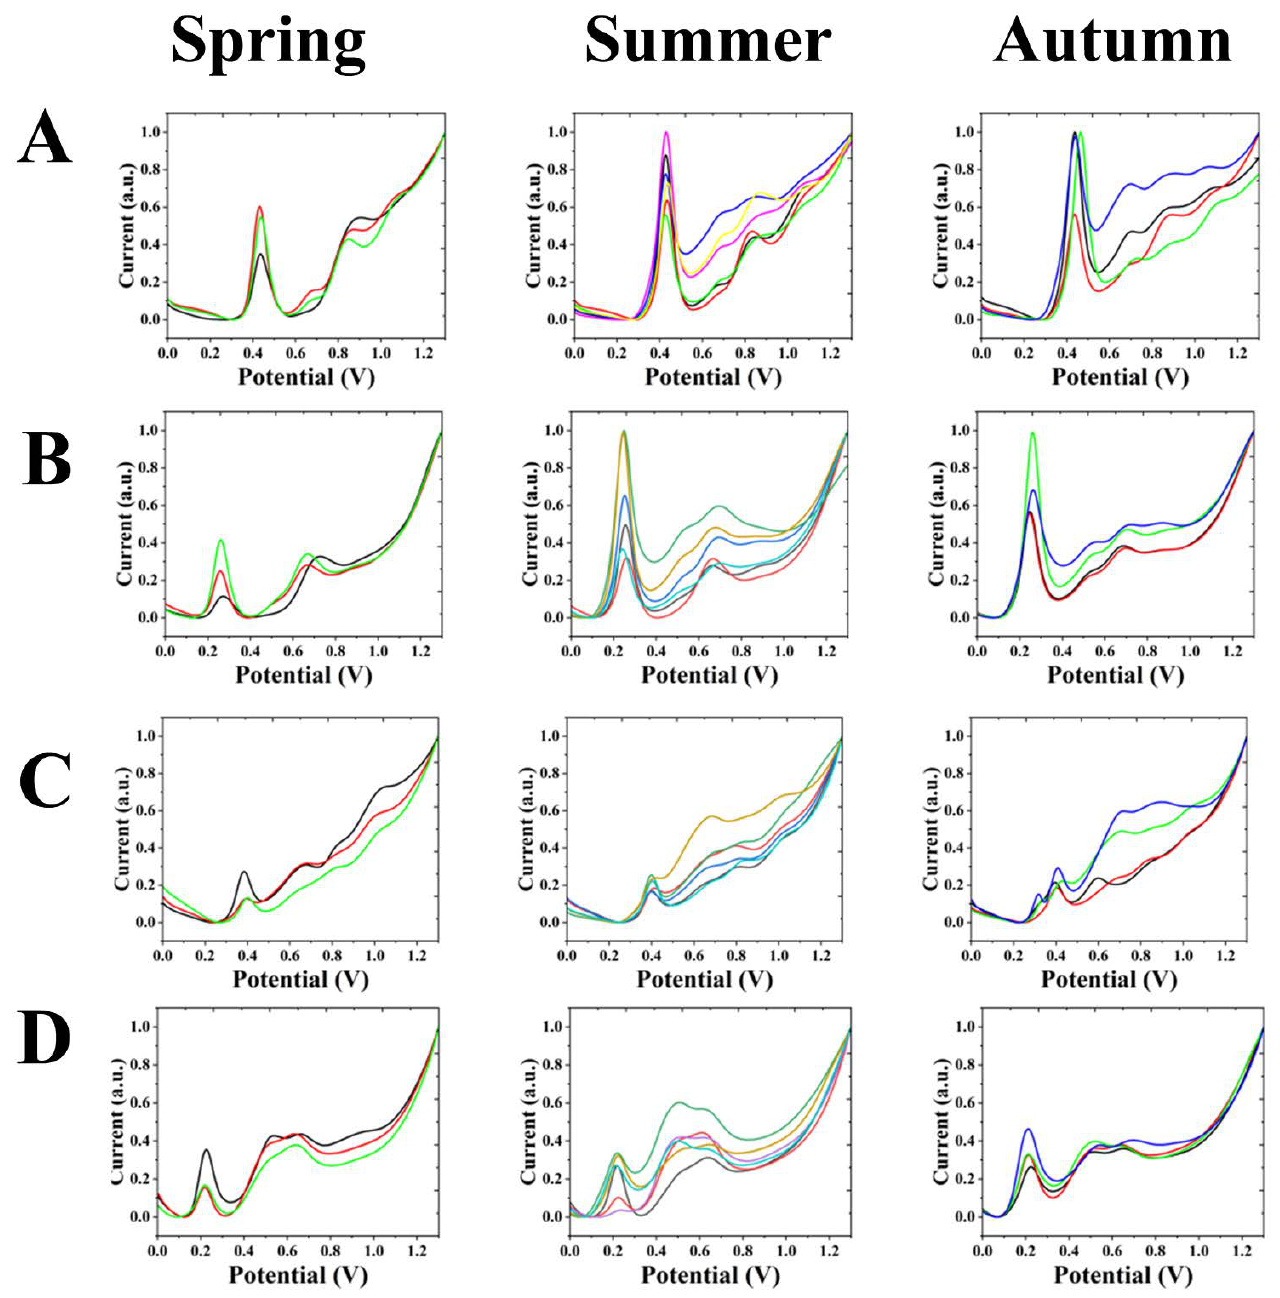
Figure 4. Electrochemical fingerprints of A. sinopurpurascens in different seasons under ( A ) water-ABS, ( B ) water-PBS, ( C ) ethanol-ABS and ( D ) ethanol-PBS conditions.